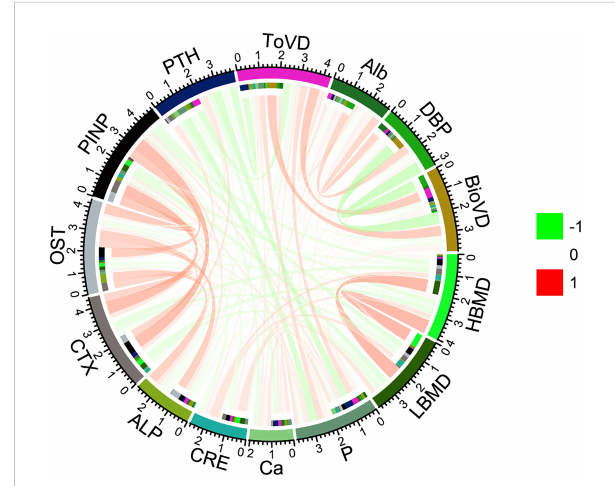
FIGURE 2 Spearman correlations among serum measures and BMD. The correlation coef fi cient between each pair of parameters is shown with a speci fi c color and width of the line. Red lines represent positive correlations and green lines negative correlations. HBMD, Hip Bone Mineral Density; LBMD, lumbar bone mineral density; P, Phosphorous; Ca, Calcium; CRE, Creatinine; ALP, alkaline phosphatase; CTX, b -Cross Laps of type I collagen containing crosslinked C-telopeptide; OST, osteocalcin; PINP, N-terminal propeptide of type I procollagen; PTH, parathyroid hormone; ToVD, Total 25(OH)D; Alb, Albumin; DBP, vitamin D binding protein; BioVD, bioavailable